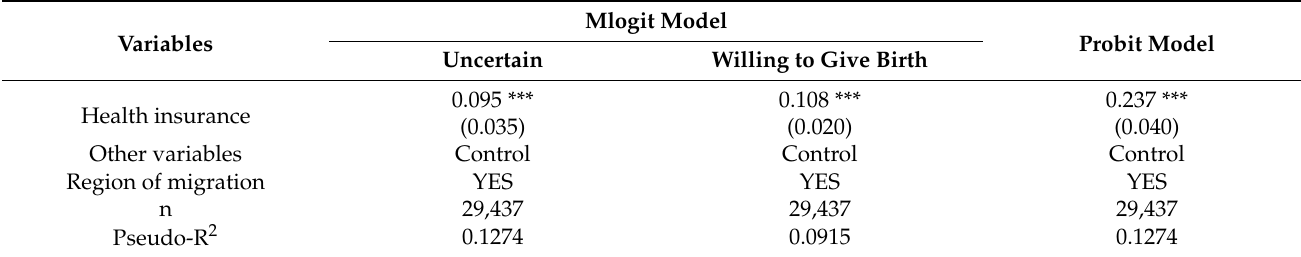
Table 4. Results of the robustness test.